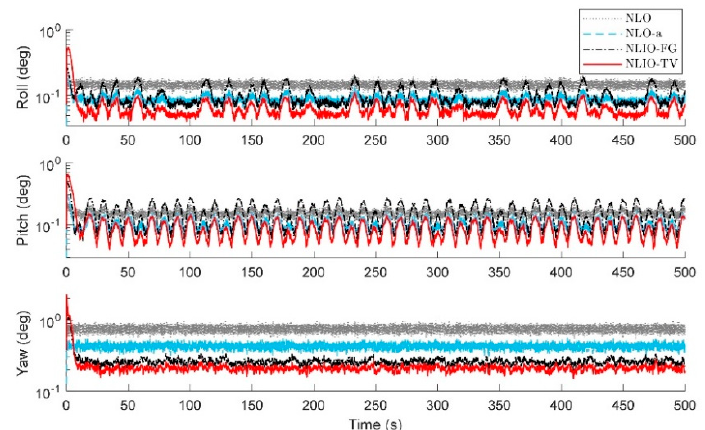
Figure 7. Averaged absolute attitude estimation error over 100 simulations for Case 2.